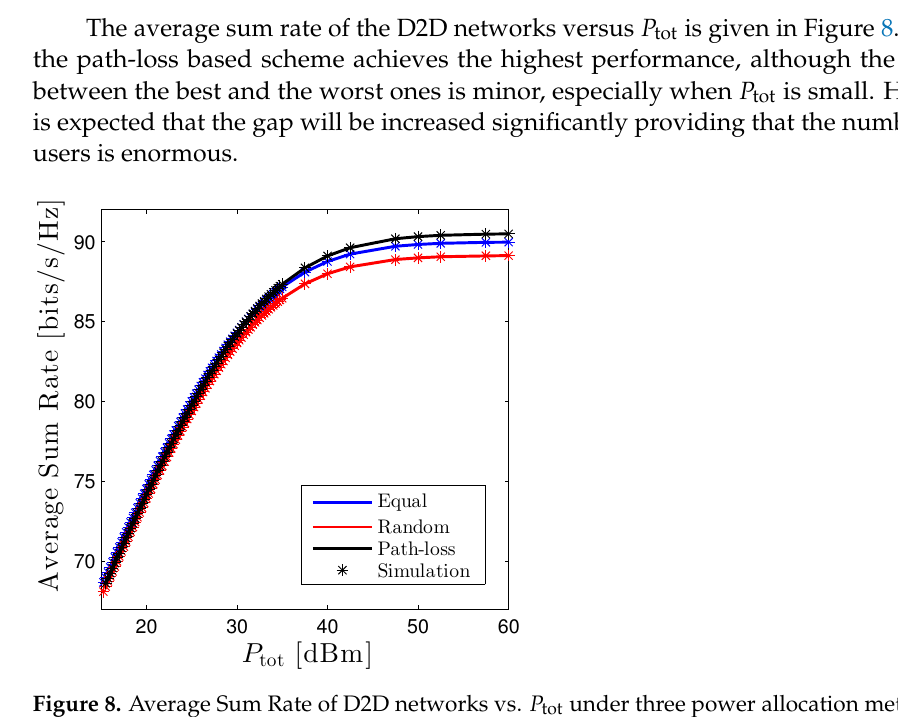
Figure 7. Average rate of the first D2D pairs vs. P tot under three power allocation methods. Solid lines are plotted by employing (13) and markers are Monte Carlo simulation.